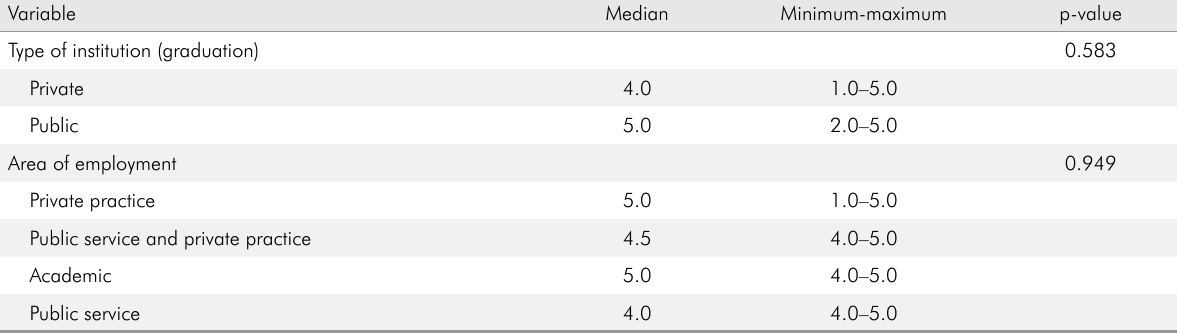
Table 4. Comparison of degree of updatedness in MID, between the categories of independent variables.